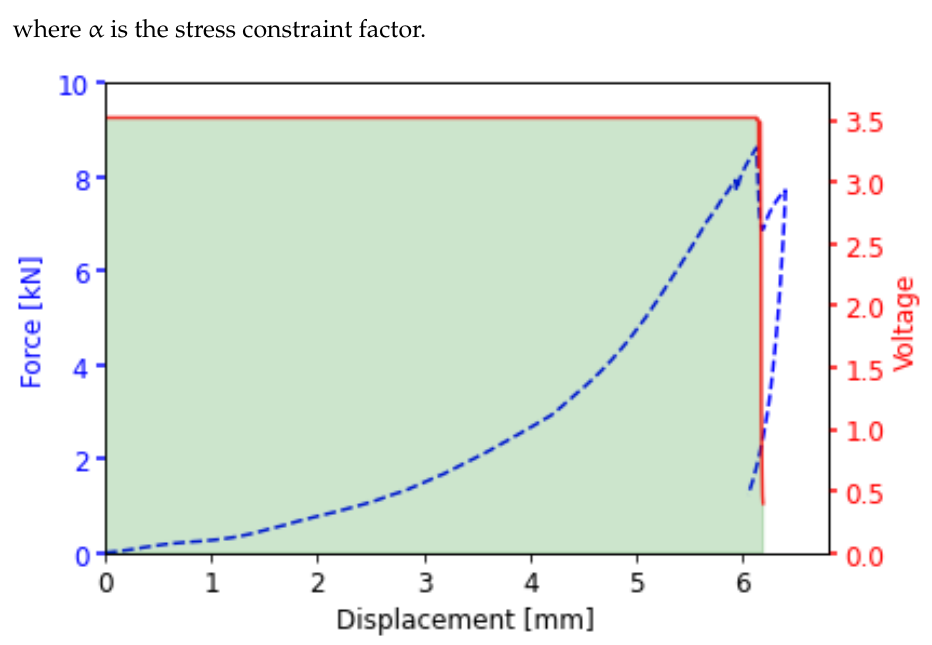
Figure 5. Measured indentation load – depth data.